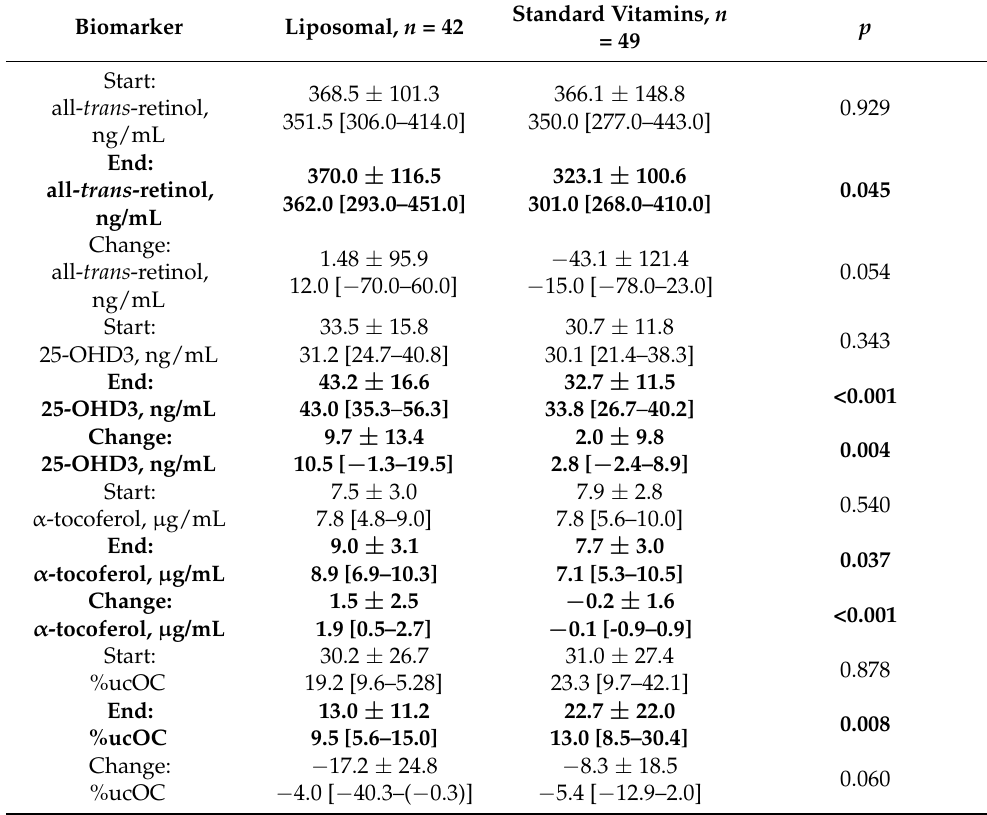
Table 4. Changes in fat-soluble vitamin concentration and their levels in pancreatic-insufficient CF patients before and after supplementation with the novel liposomal formulation and the standard forms (control). Mean ± SD are given, along with two-sided p values from the unequal variances t test (statistically significant differences are presented in bold). Please note that the percentage of undercarboxylated osteocalcin reflects the functional insufficiency of vitamin K, hence lower concentrations and negative changes should be interpreted as